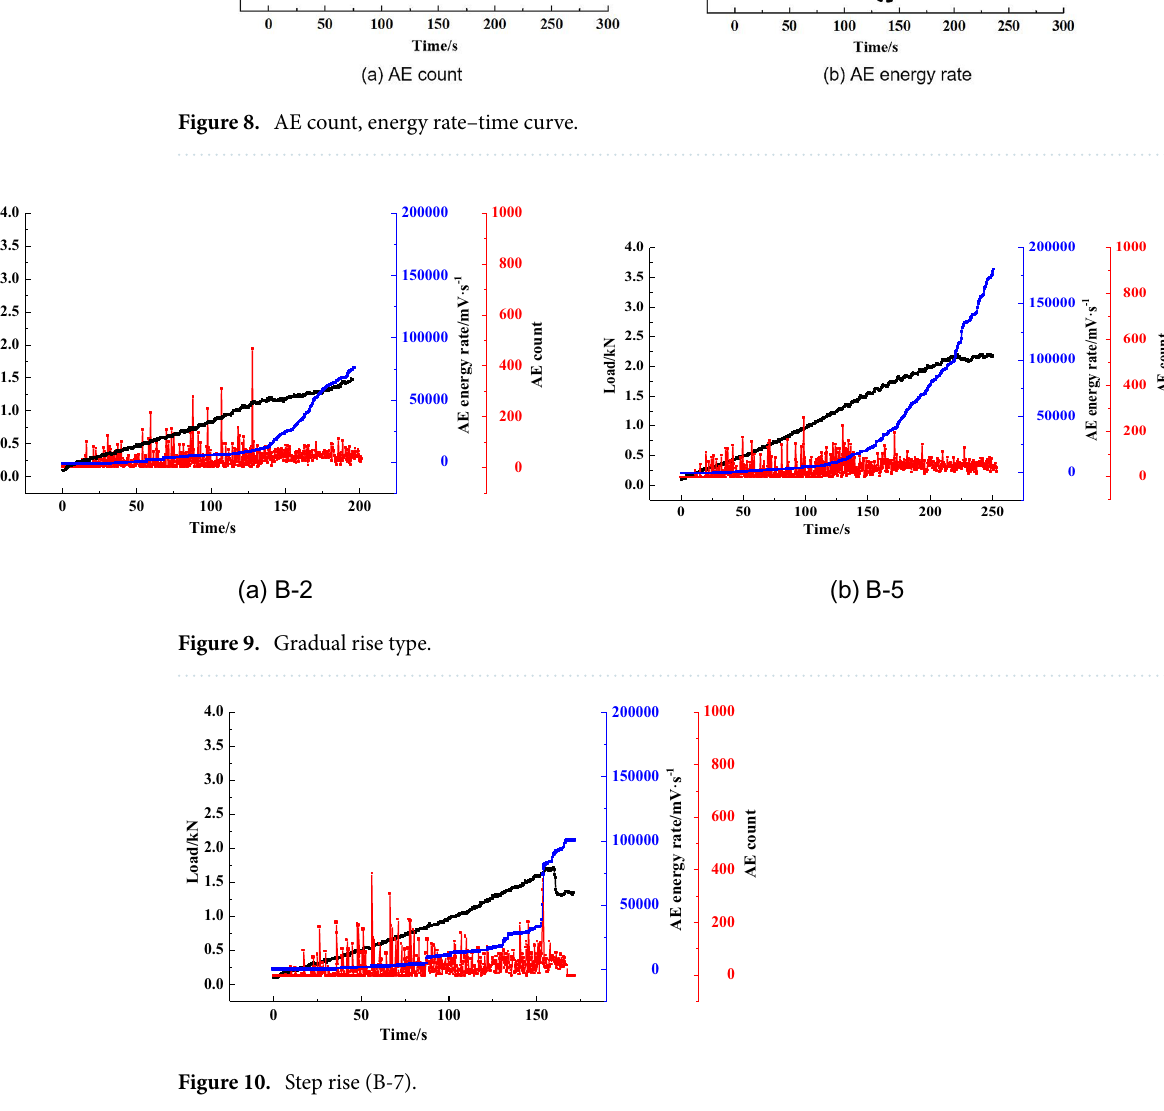
Figure 10. Step rise